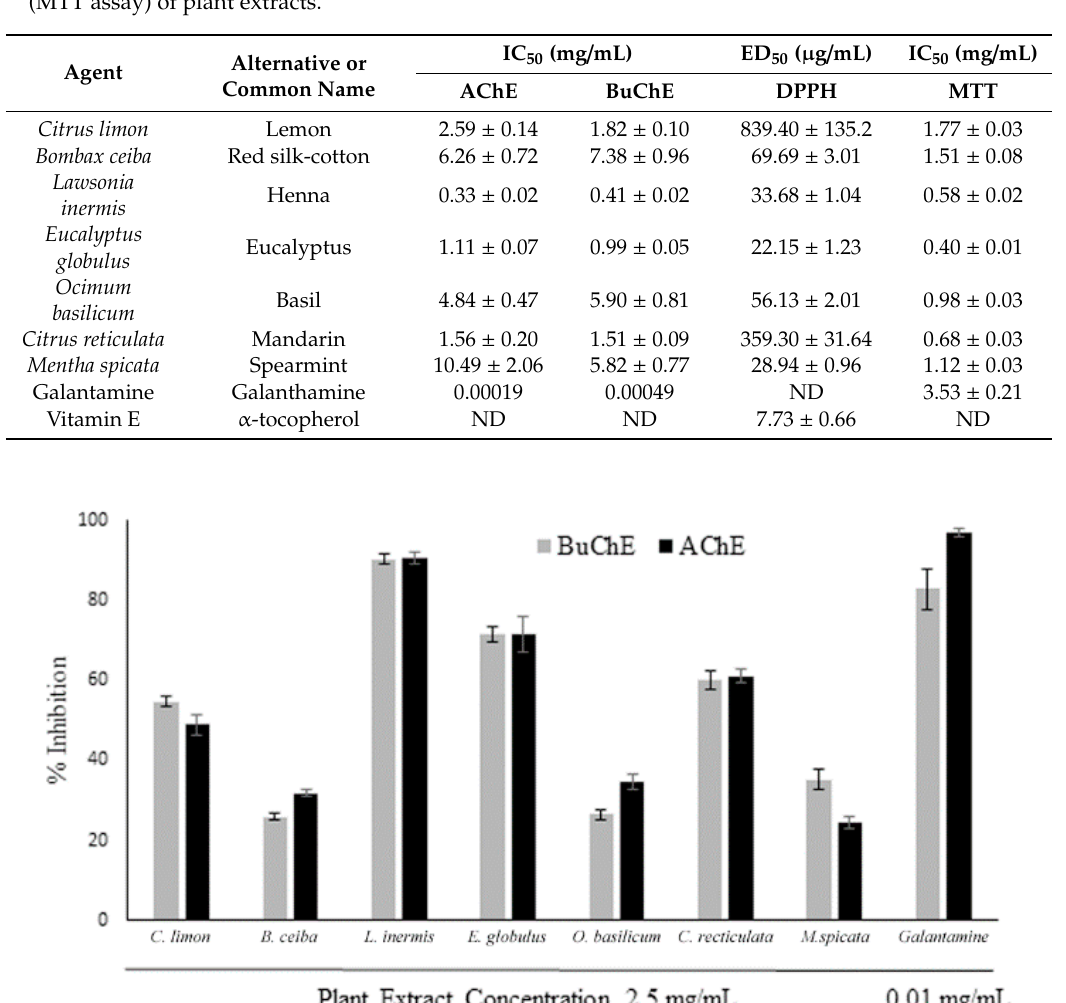
Table 1. AChE and BuChE inhibitory capacity, DPPH radical scavenging, and cell viability assessment (MTT assay) of plant extracts.